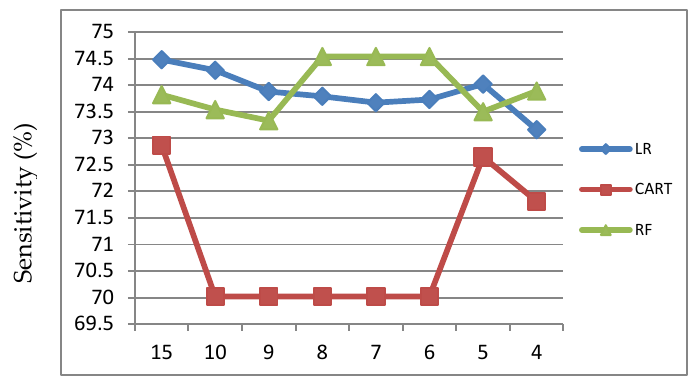
Figure 4. Accuracy of LR, CART and RF with input of important variables identified by CART.